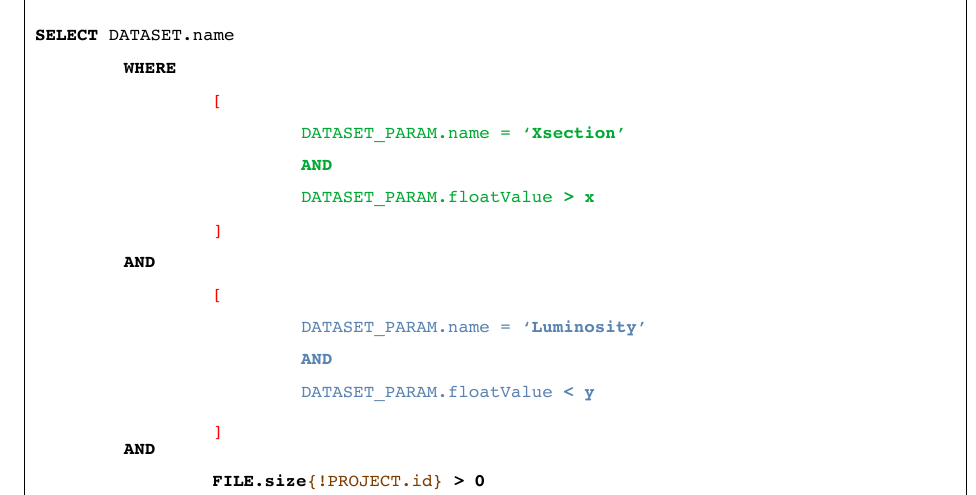
Figure 5. Example of MQL query based on the database schema Section 2.2. If the constraint {!PROJECT.id} is not specified, the generated SQL will follow all possible paths to reach the “FILE”